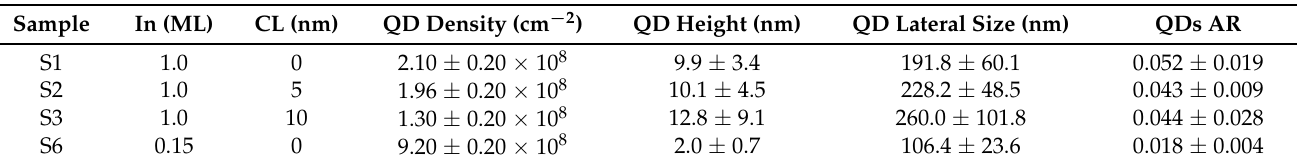
Table 3. Average morphological features of QDs grown with different In MLs measured with AFM on the samples covered by CLs of different